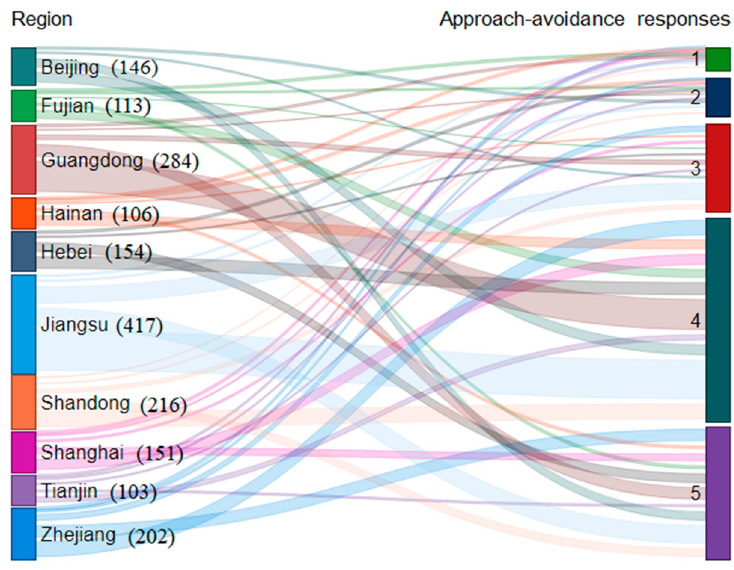
Figure 1. The regional distribution of the samples and the regional contribution to each level of approach–avoidance responses (AAR). Table 5. The regression results of psychological factors on approach–avoidance responses.